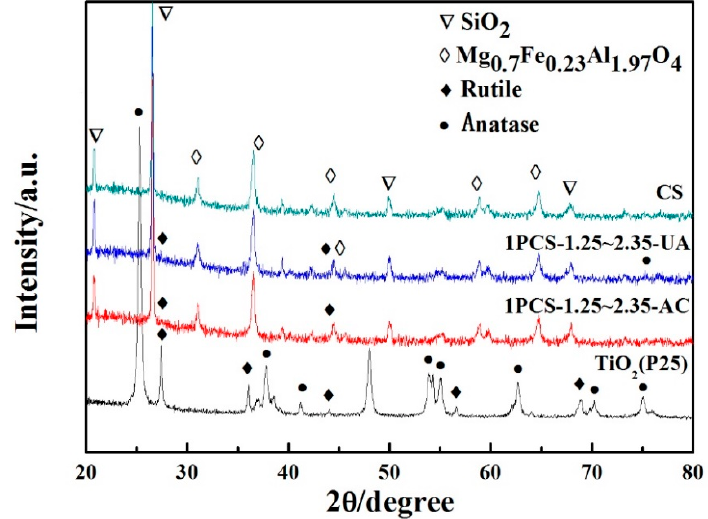
Figure 3. X-ray diffraction patterns of CS, TiO 2 (P25), 1PCS-1.25~2.35 with ultrasonic activation (1PCS-1.25~2.35-UA) and alkali activated (1PCS-1.25~2.35-AC).